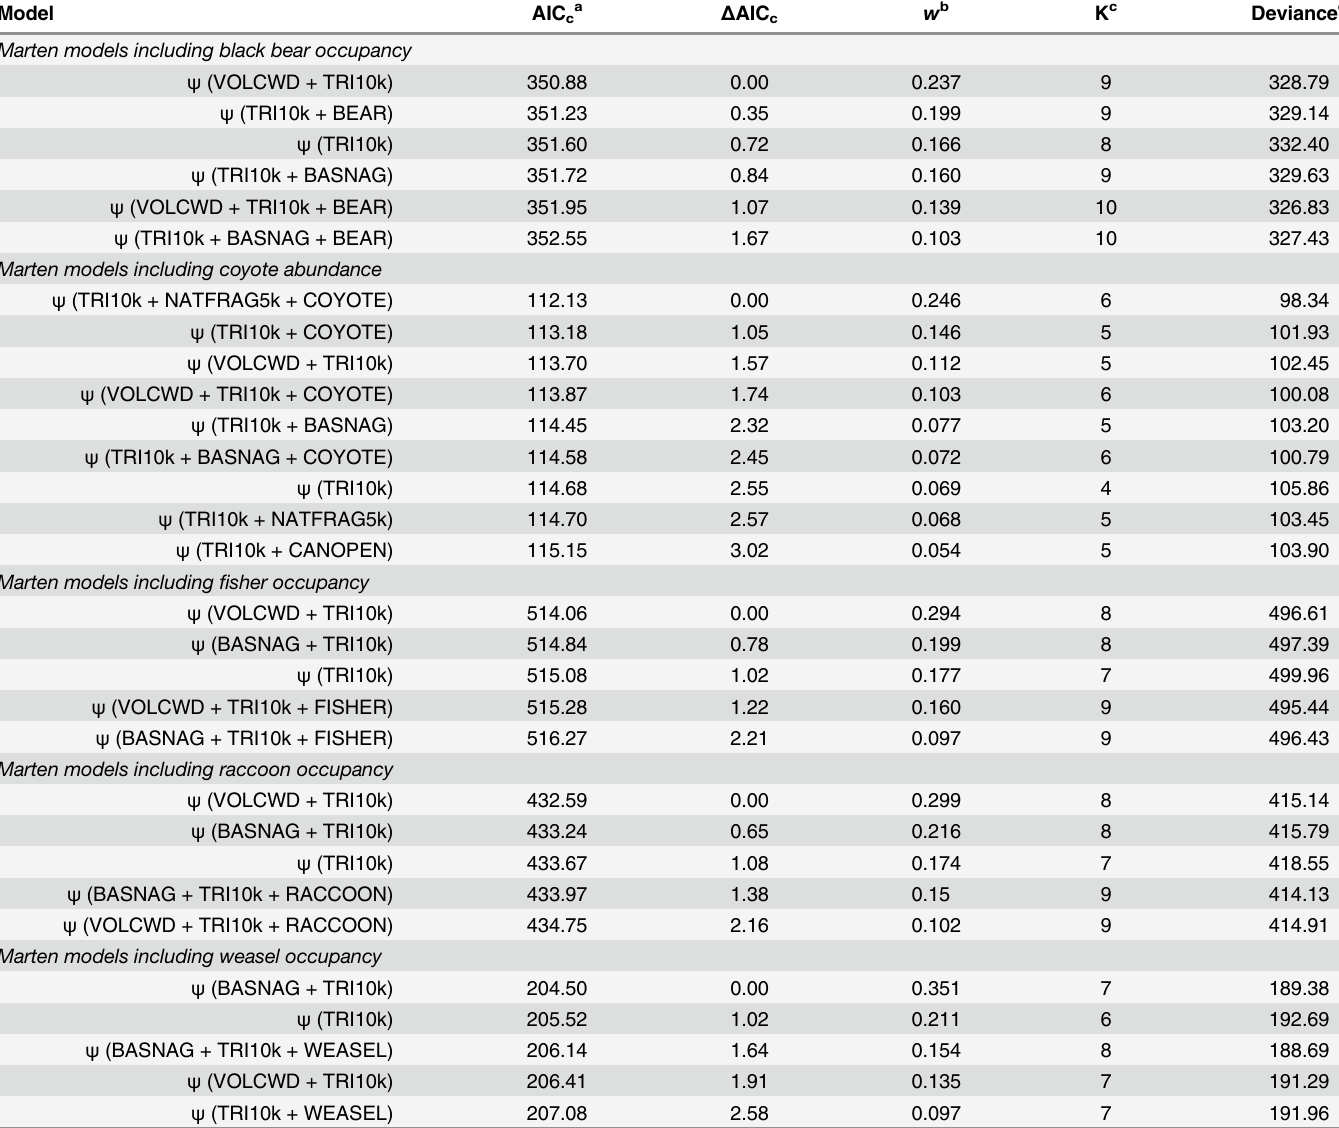
Table 4. Marten co-occurrence models. Co-occurrence model selection results in the 90% confidence set for M . americana with the inclusion of U . ameri- canus , C . latrans , M . pennanti , P . lotor , and Mustela spp. We fit encounter history data from surveys at 54 sites in Adirondack Mountains, New York, USA to each candidate model set. Co-occurrence models were fit using important detection parameters and estimated occupancy, except C . latrans models which were fit using estimated abundance. See S1 Table for habitat variable descriptions.